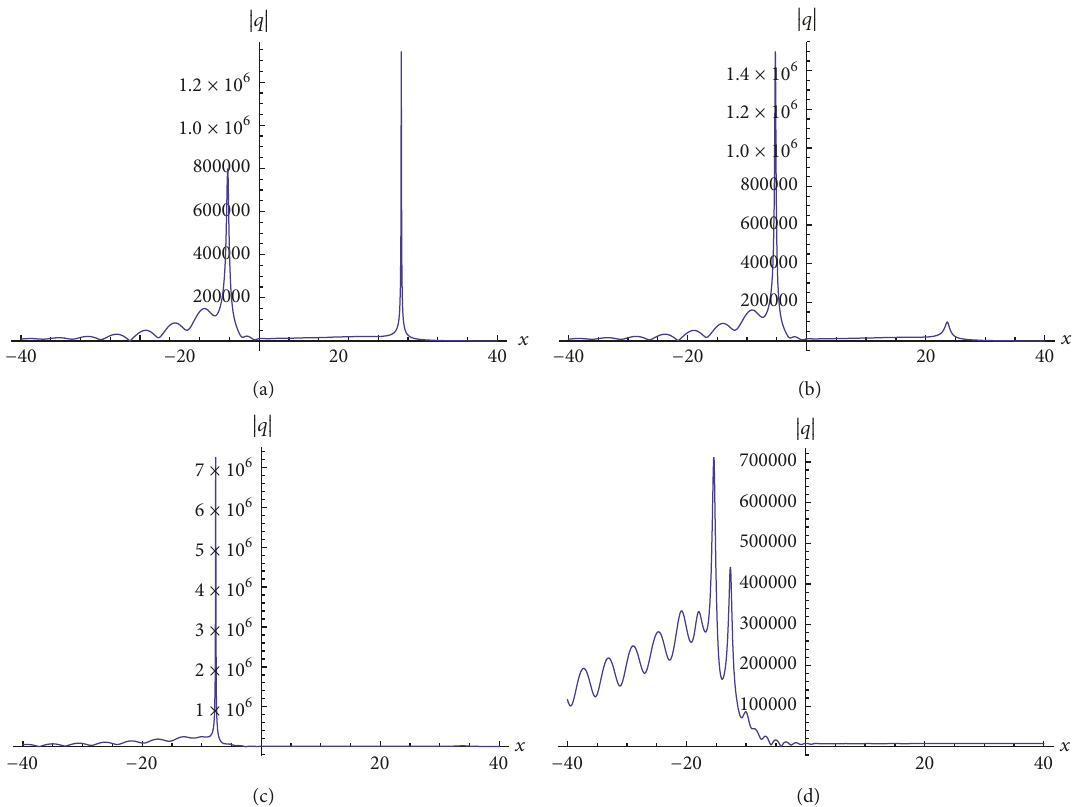
Figure 3: Dynamical evolutions of two-soliton solution determined by (66) at different times: (a) 𝑡 = −11.112 , (b) 𝑡 = −11.104 , (c) 𝑡 = −11 , and (d) 𝑡 = −10.94 .